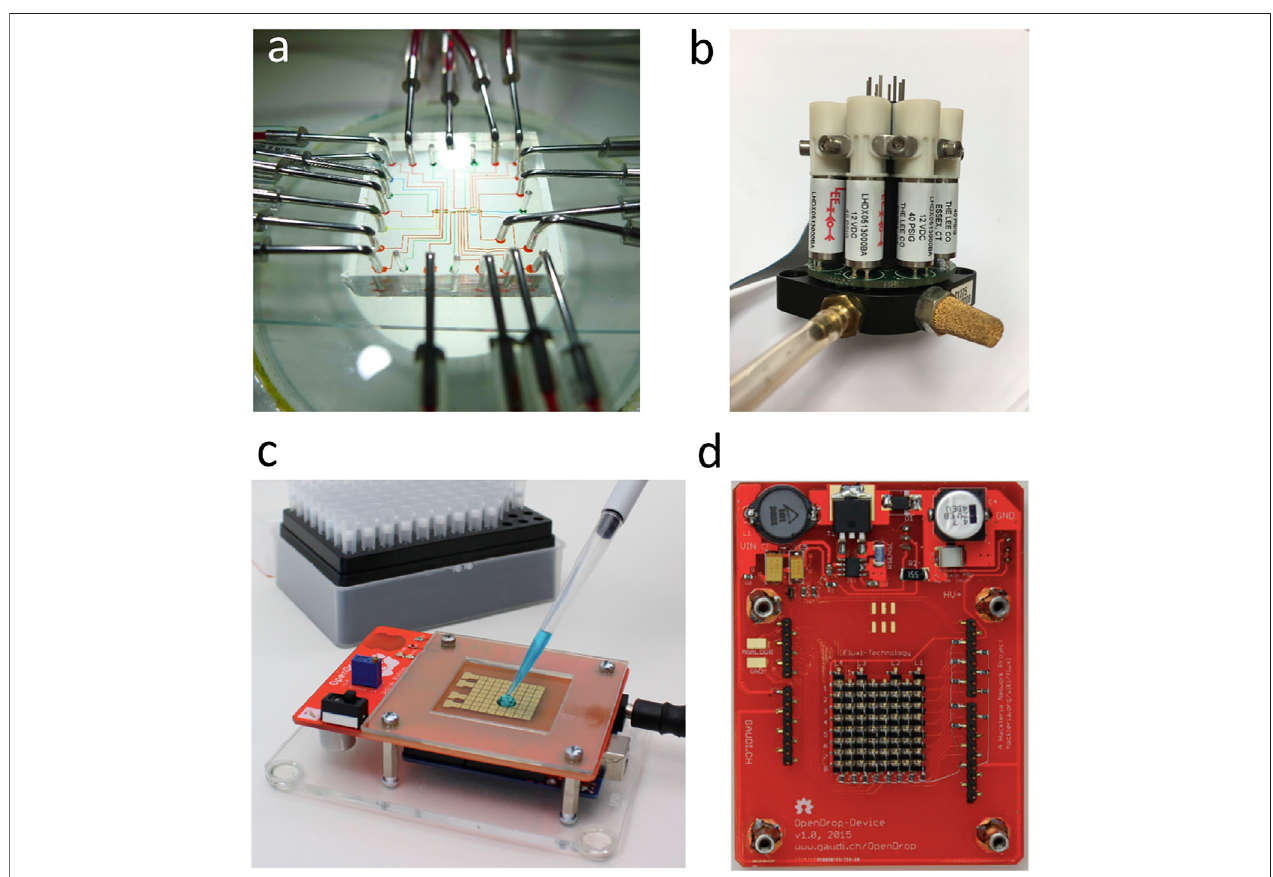
FIGURE 1 | Micro fl uidics based on soft lithography vs. digital micro fl uidics. (A) Micro fl uidic chip built with multi-layer soft lithography. Microchannels are colored with food dye. Stainless steel tubes are used to provide the fl uid input and pneumatic control. (B) Manifold of solenoidal valves used in pneumatically controlled micromechanical membrane valves of a micro fl uidic chip based on soft lithography (Photo by Ya-Tang Yang). (C) OpenDrop is an example of digital micro fl uidics. OpenDrop consists of an array of electrodes and uses an electrical voltage to manipulate the droplet (Alistar and Gaudenz, 2017). (D) Back side of OpenDrop device showing an array of 64 fi eld effect transistors (FETs) (Alistar and Gaudenz, 2017).